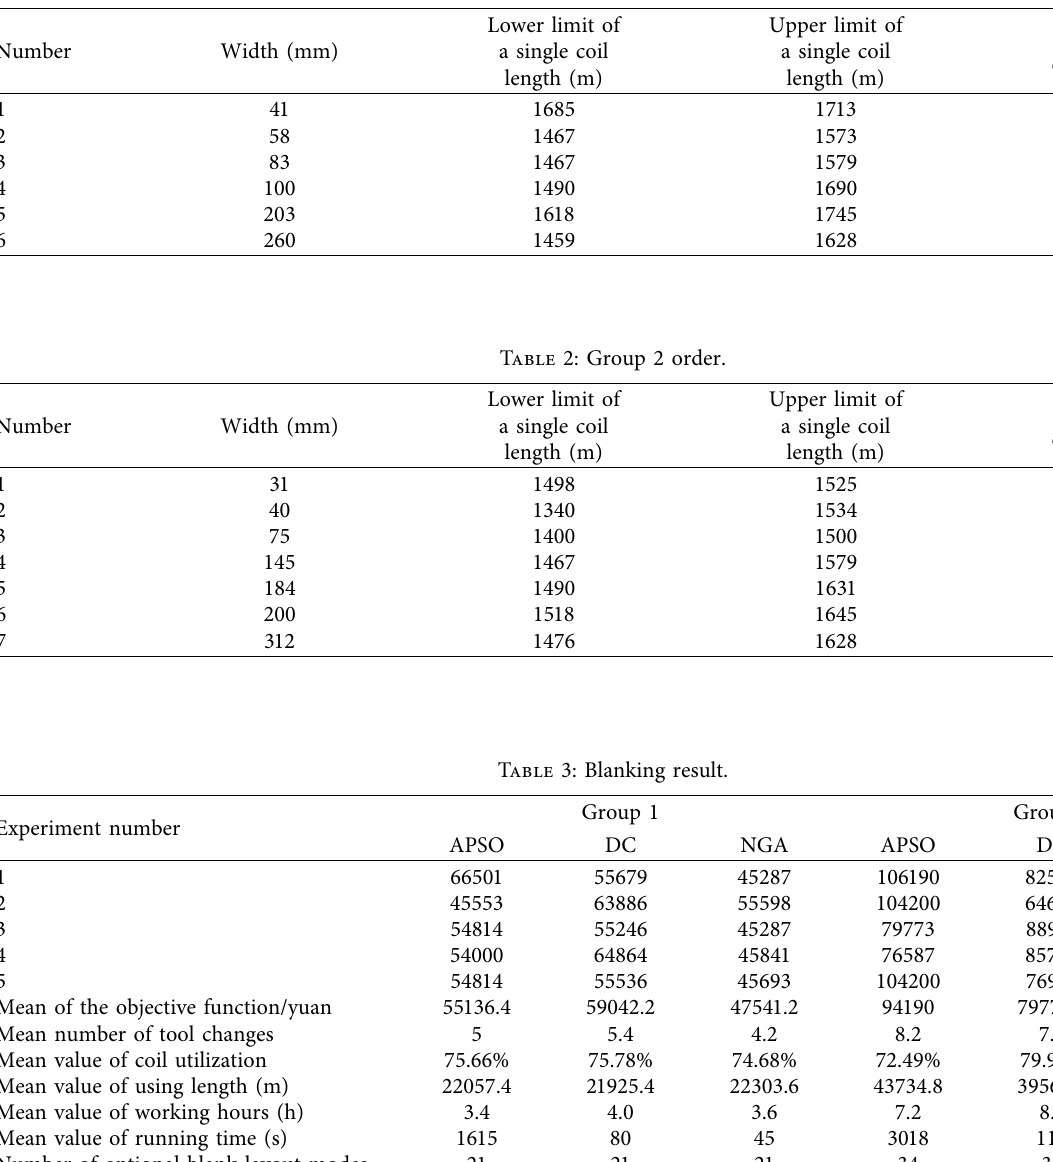
Table 1: Group 1 order.